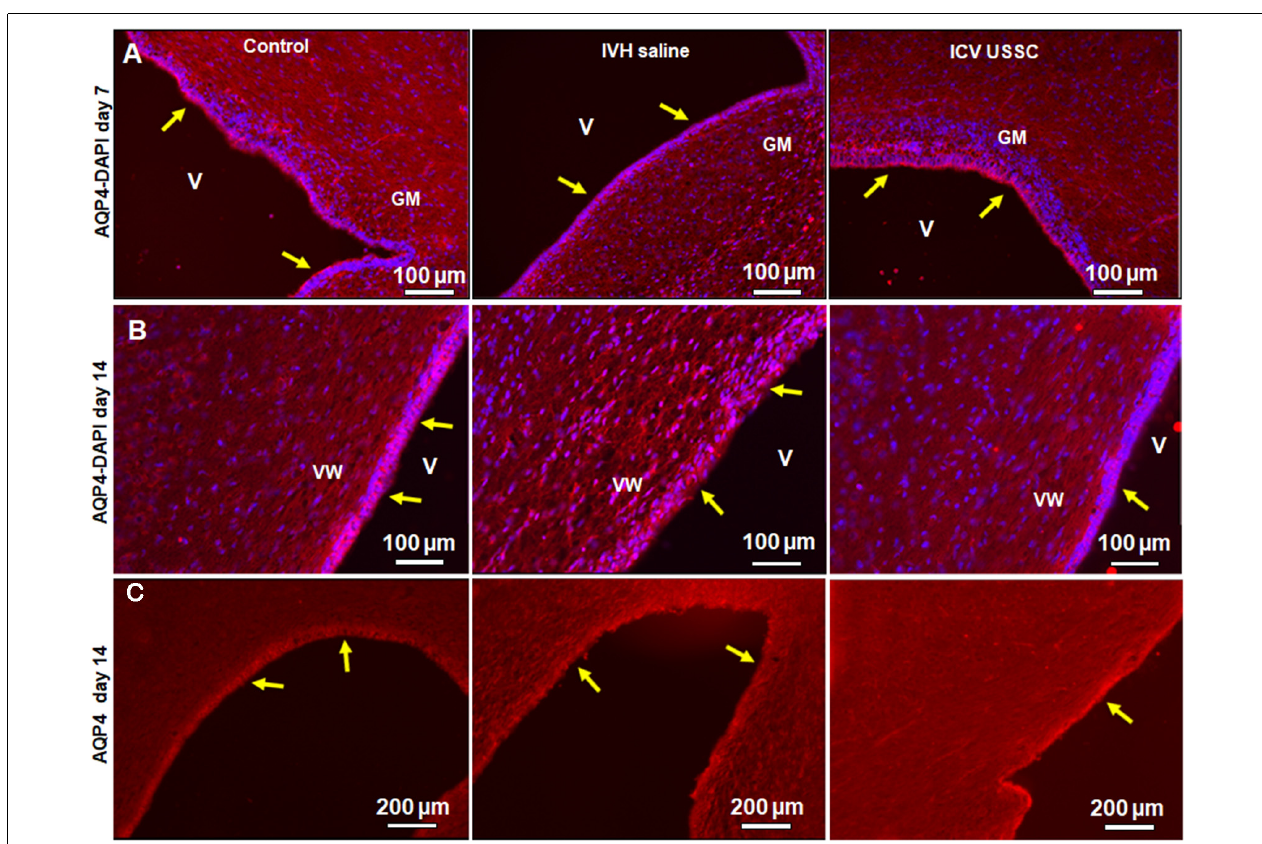
FIGURE 5 | USSC administration improved aquaporin4 (AQP4) expression in the ependymal-lining layer of the ventricle after PHH. (A) Immunofluorescence image of cryosections labeled with AQP4 specific antibody (arrows showing immunoreactivity along the ventricular wall) at postnatal days 7. Strong AQP4 immunoreactivity was observed on postnatal day 7 in the control, reduced signal in IVH followed by recovered intensify of expression in USSC treated pups around the germinal matrix (GM); images from left to right respectively (panel A ). Images were taken at GM region (20 × objective; n = 5 in each group); 20 µ m sections. V, ventricle; VW, ventricle wall; GM, germinal matrix. The scale bar is 100 µ m. (B) Strong AQP4 immuno-reactivity on day 14 in the control, reduced signal after IVH followed by recovery of intensity of expression after USSC treatment and increased cellularity (blue = DAPI); images from left to right respectively. Images were taken at lateral ventricular wall (20 × objective; n = 5 in each group); 20 µ m sections. V, ventricle; VW, ventricle wall; GM, germinal matrix. The scale bar is 100 µ m. (C) Immunofluorescence images of cryosections labeled for AQP4. The AQP4 in the ventricle wall was higher as seen in panel (B) in the control group and showed reduced and discontinuous signal after IVH followed by recovered to strong AQP4 expression after USSC treatment. The images were from left to right for control, IVH and IVH USSC injected pups respectively at day 14. Images were taken covering the major ventricular area at 10 × objective ( n = 5 in each group) 20 µ m sections. V, ventricle; VW, ventricle wall, GM, germinal matrix. The scale bar is 200 µ m. Fluorescence images were obtained using “Nikon Eclipse 90i microscope” (Nikon Instruments,